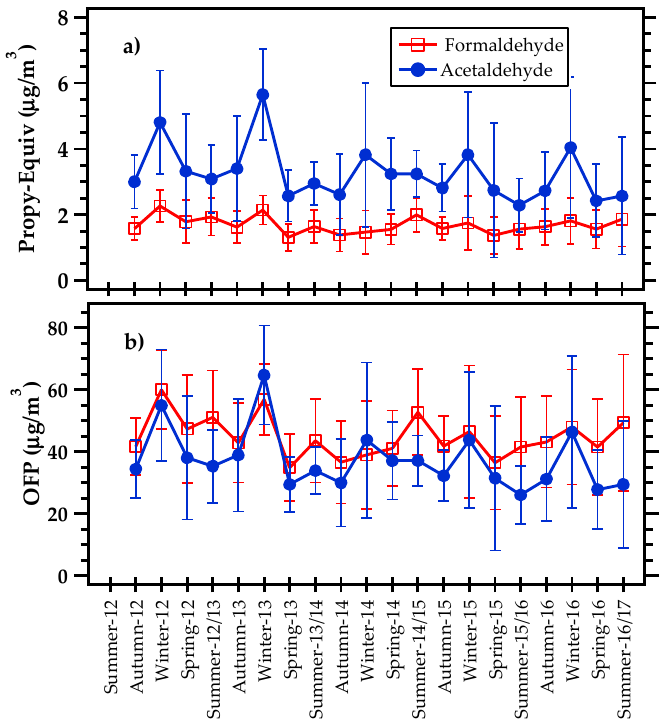
Figure 7. Mean propy-equiv ( a ) and ozone formation potential (OFP) ( b ) values for concentrations of formaldehyde and acetaldehyde in the Metropolitan Area of São Paulo between 2012 and 2016.